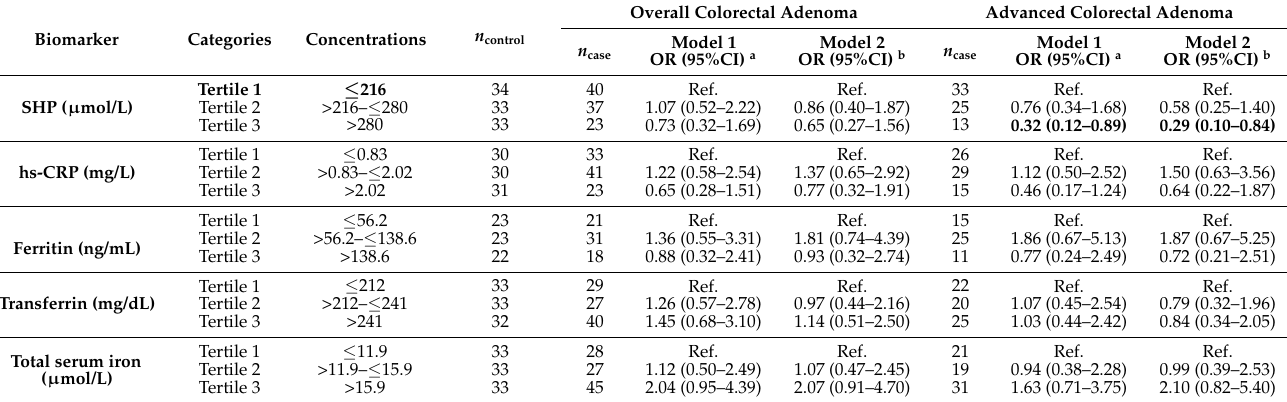
Table 5. Odds ratios and 95% confidence intervals for the associations of biomarkers of oxidative stress, inflammation and body-iron stores concentration tertiles with overall as well as advanced colorectal